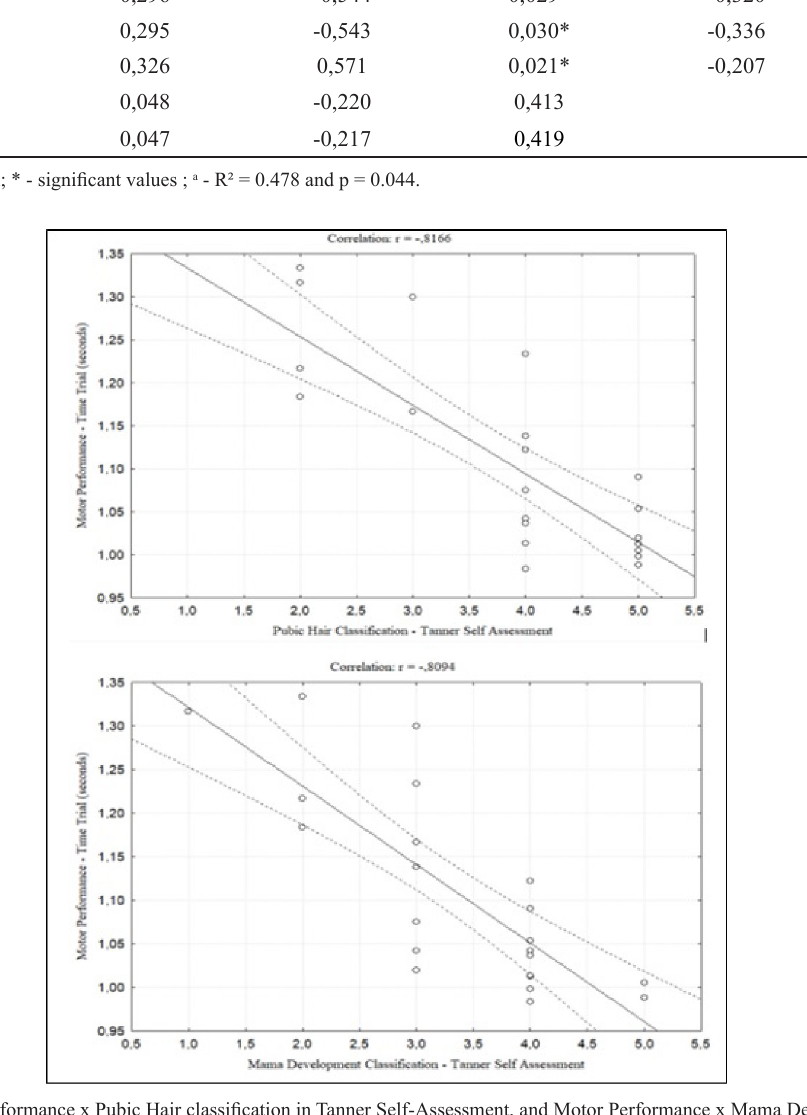
Figure 1 - Scarplott – Motor Performance x Pubic Hair classification in Tanner Self-Assessment, and Motor Performance x Mama Development Classification in Tanner